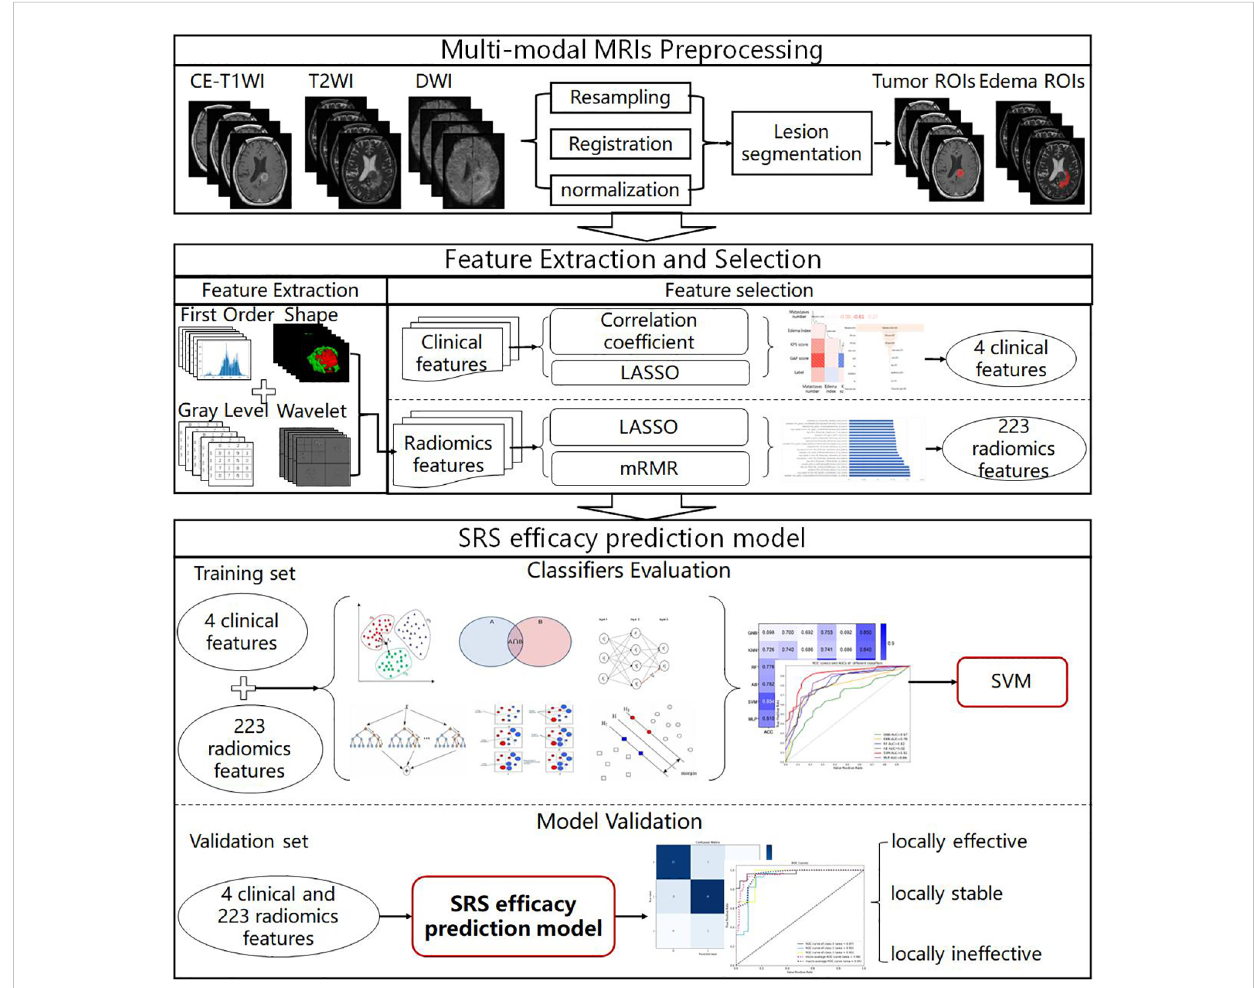
FIGURE 1 MRI data analysis fl